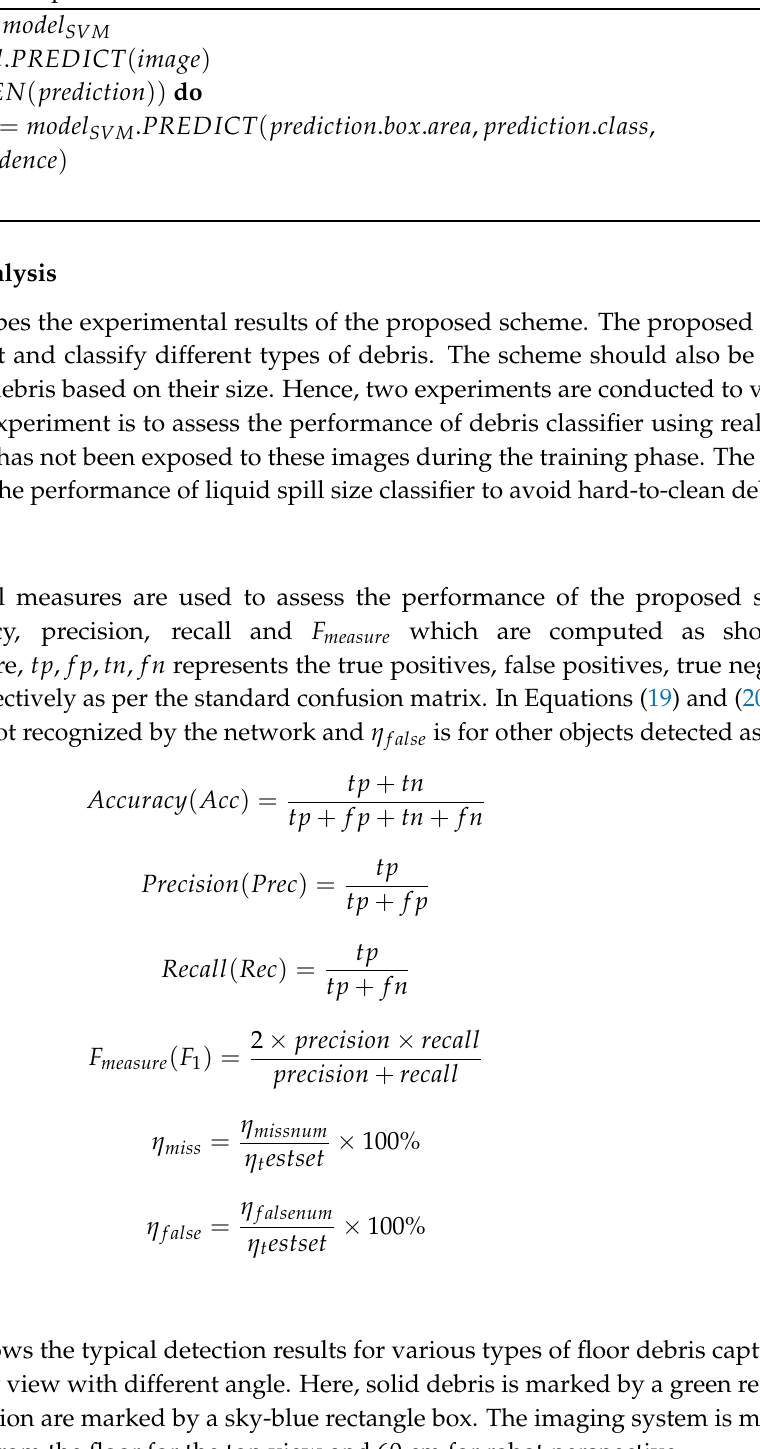
Algorithm 2: Simulation-optimization